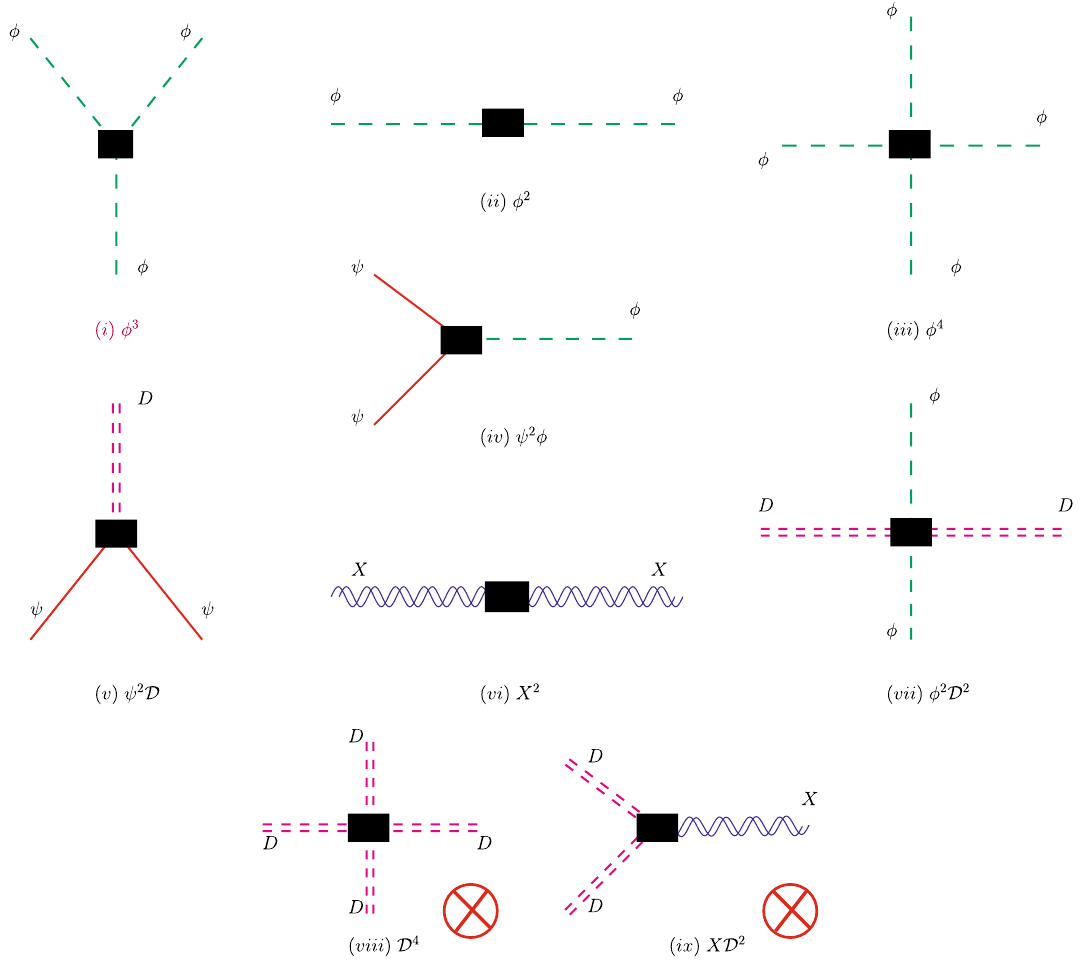
appearinthecaseofSMhencewehavehighlighteditscaptionincolour. Also, the last two structures being total derivative terms are excluded from the